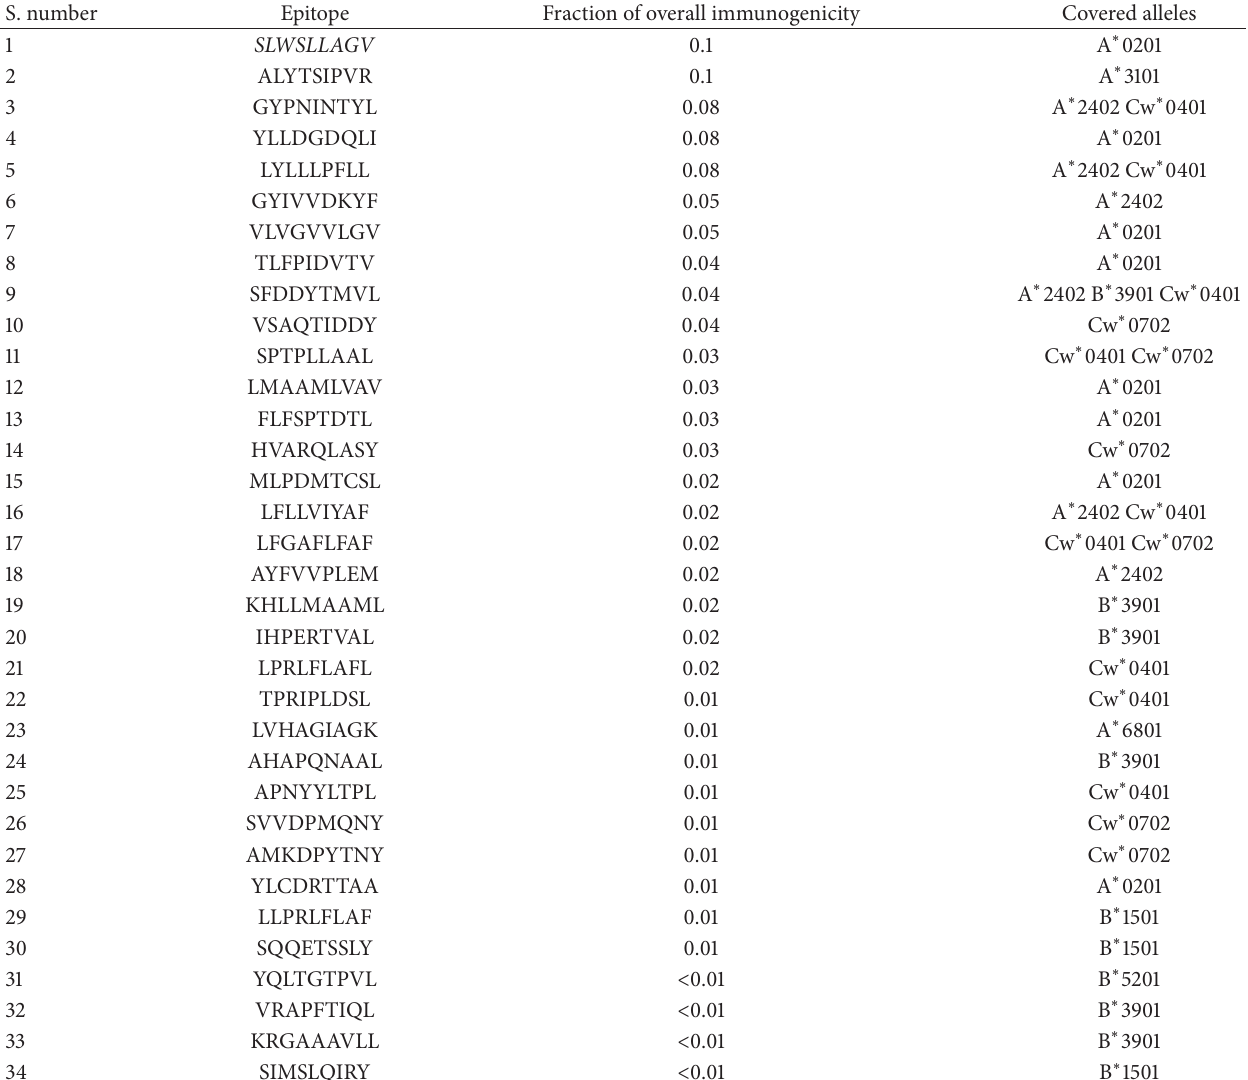
Table 6: The distribution of fractional immunogenicity for the 34 optimal epitopes against the population of South America. S.